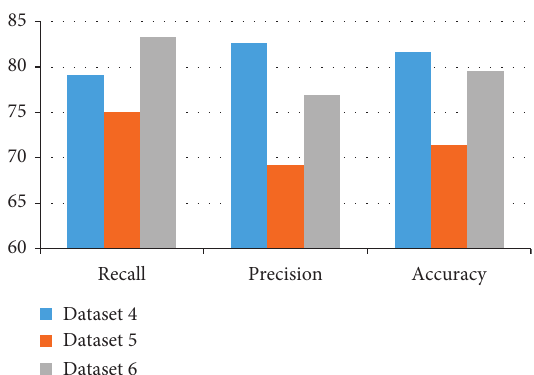
Figure 2: Comparison of judgment results among Datasets 4–6.